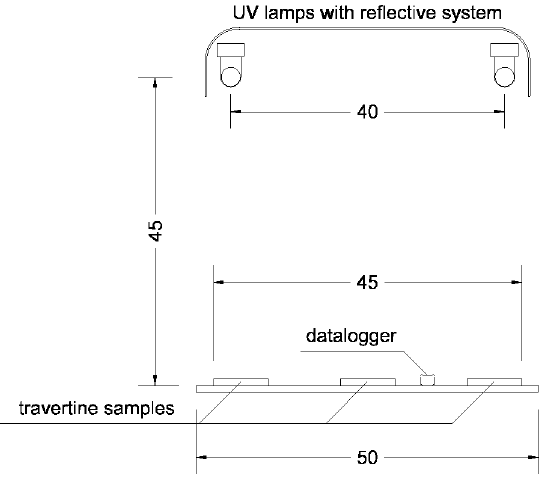
Figure 1. Diagram of the laboratory system used to perform the self-cleaning